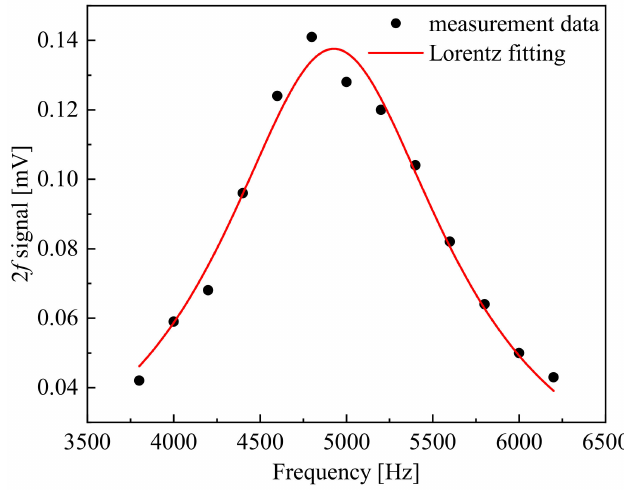
Figure 4. Frequency response of the photoacoustic cell. The data can be fitted well by a Lorentz fitting.